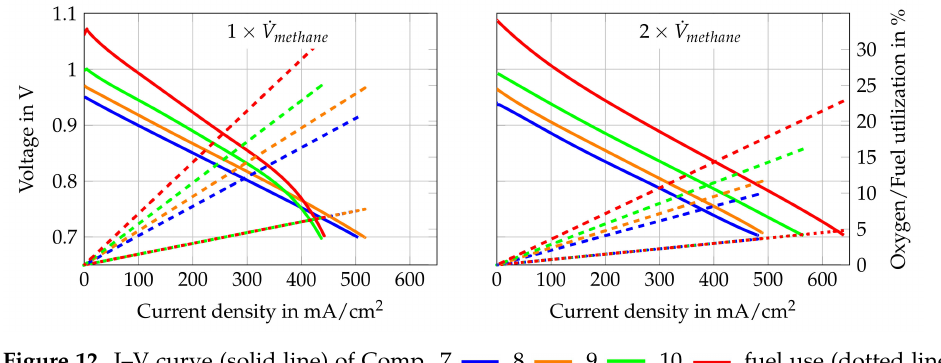
Figure 12. I–V curve (solid line) of Comp. 7